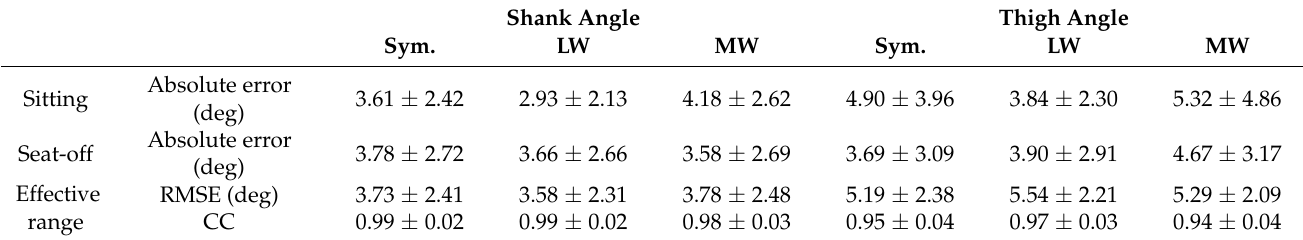
Table 5. Errors of segment angles in the proposed system. Shank Angle Thigh Angle Sym. LW MW